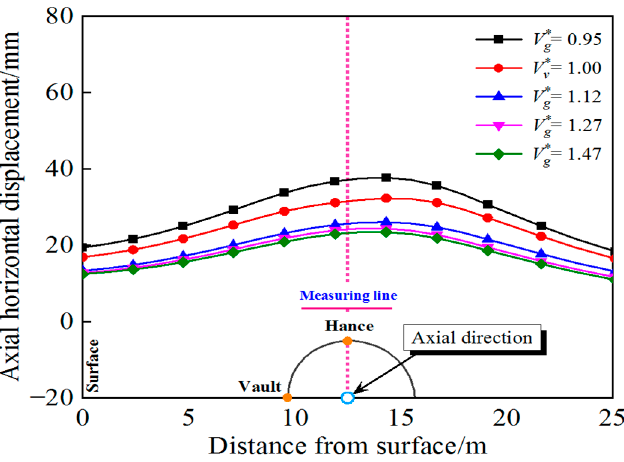
Figure 26. Horizontal deformation of the stratum along the transverse direction under different